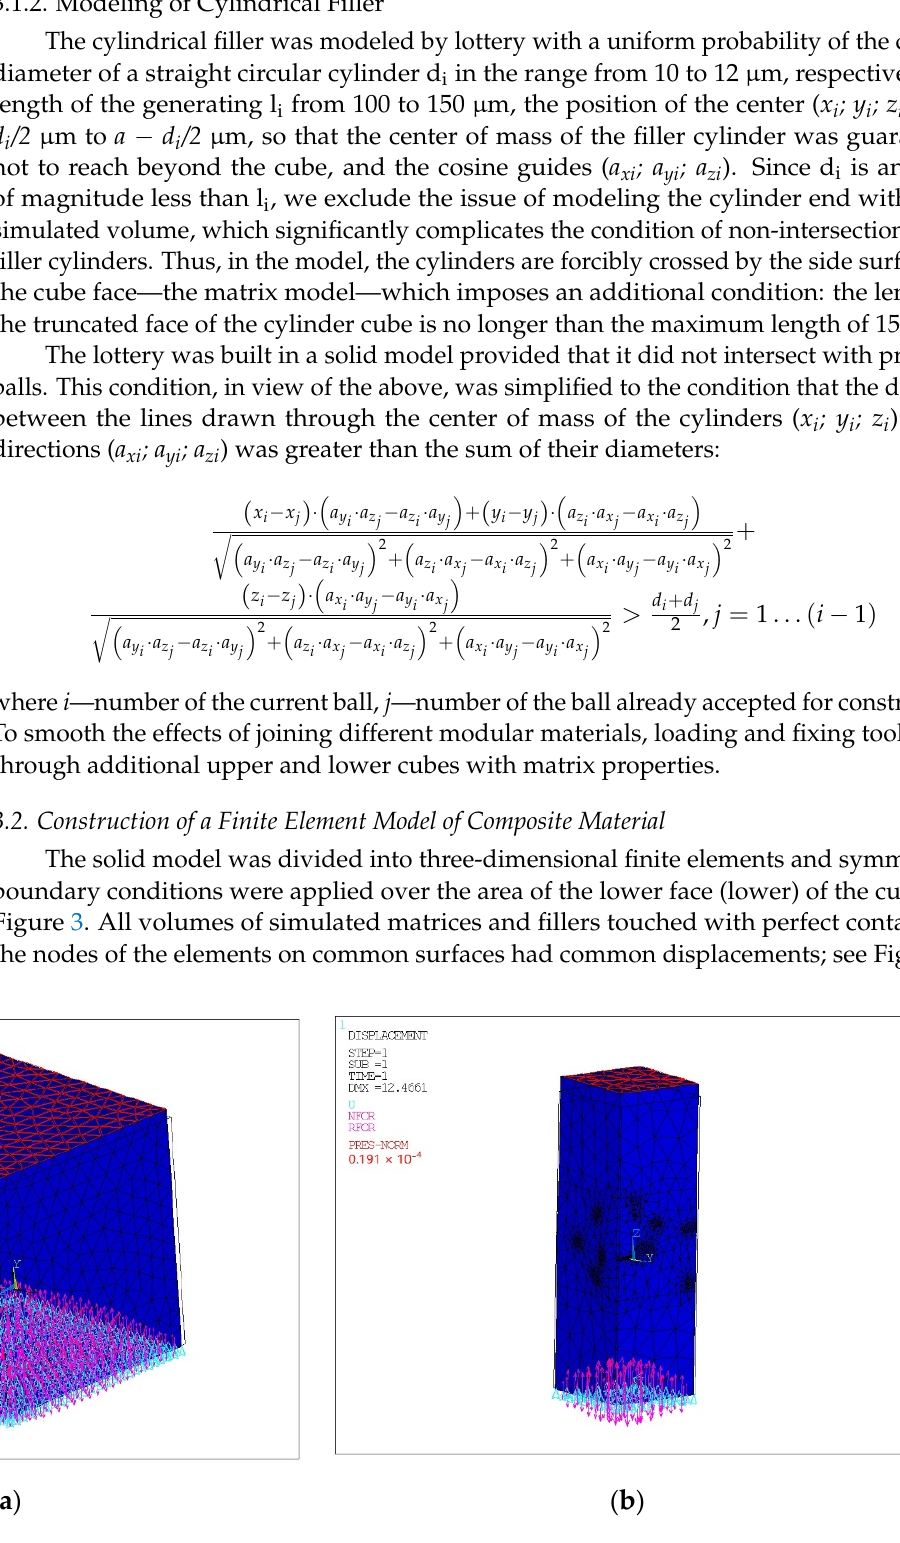
Figure 3. Deformable state of a finite element model of composite materials chaotically reinforced with spherical ( a ) and cylindrical ( b ) inclusions with applied boundary conditions and reactions.